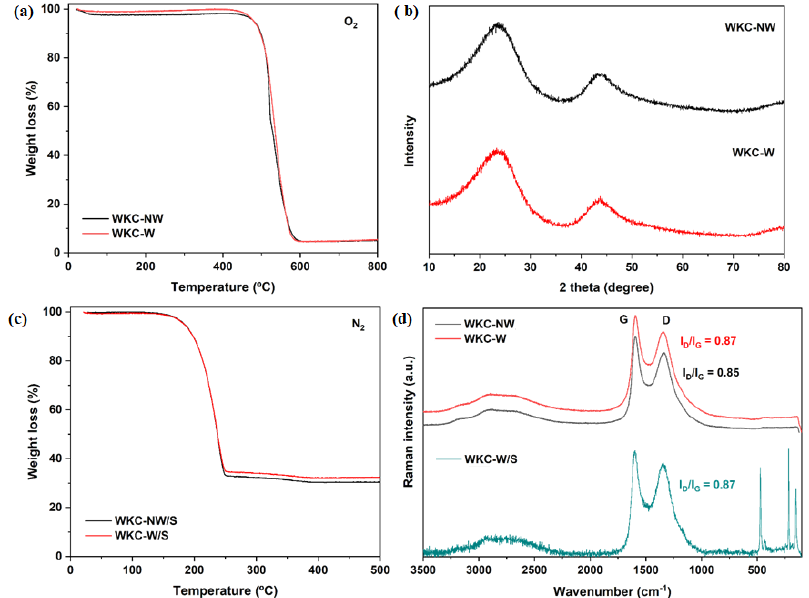
Figure 5. TG curves in oxygen ( a ), XRD patterns ( b ), TG curves in nitrogen ( c ) and Raman spectra ( d ) for WKC-NW, WKC-W and WKC-W/S.